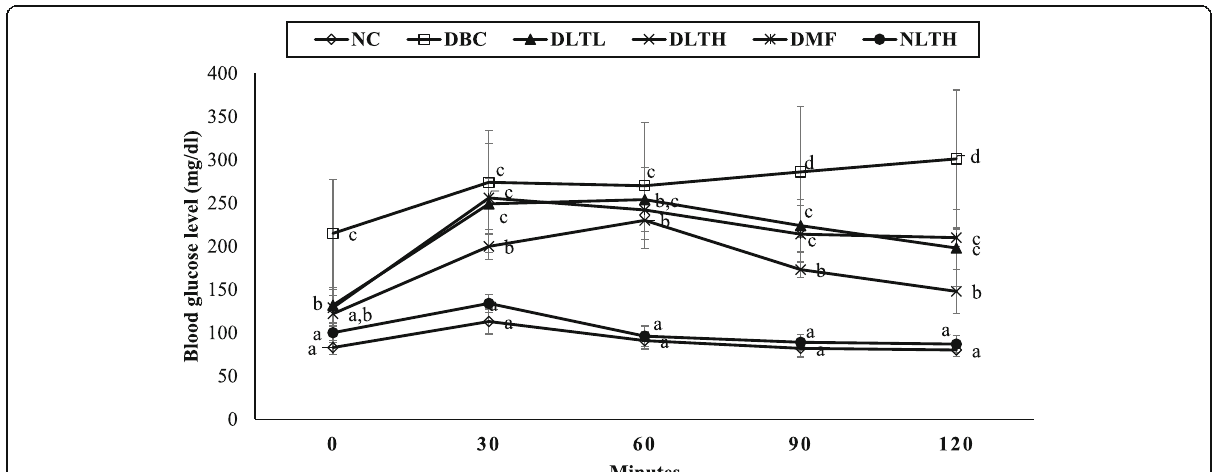
Fig. 4 OGTT of different animal groups during the experimental period. Data are presented as the mean ± SD of 6 animals. a – c Values with different letters over the bars for a given parameter are significantly different from each other group of animals (Tukey ’ s-HSD multiple range post hoc test, p < 0.05). NC- Normal control; DBC- Diabetic control; DLTL- Diabetic lemongrass tea low; DLTH- Diabetic lemongrass tea high; DMF- Diabetic metformin; NLTH- Normal lemongrass tea high